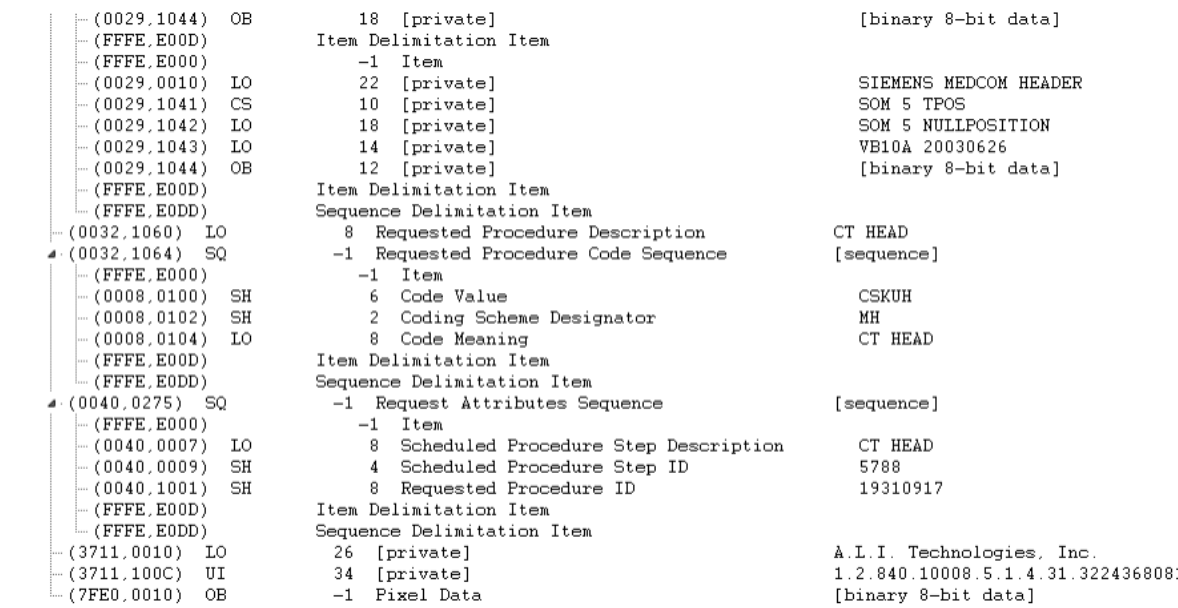
Figure A4. DICOM header data before de-identification (part